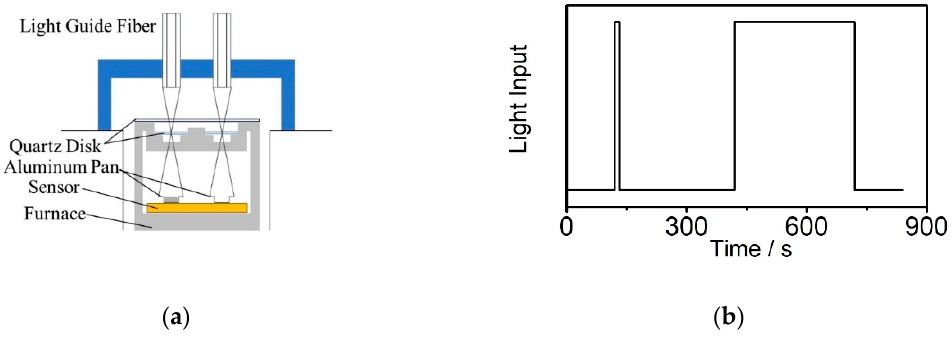
Figure 2. Photo-DSC structure and exposure program: ( a ) the cross-section structure of the photo-DSC furnace where ( b ) the curing program is composed of two parts: the preliminary exposure time and the complete cure time of the resin.